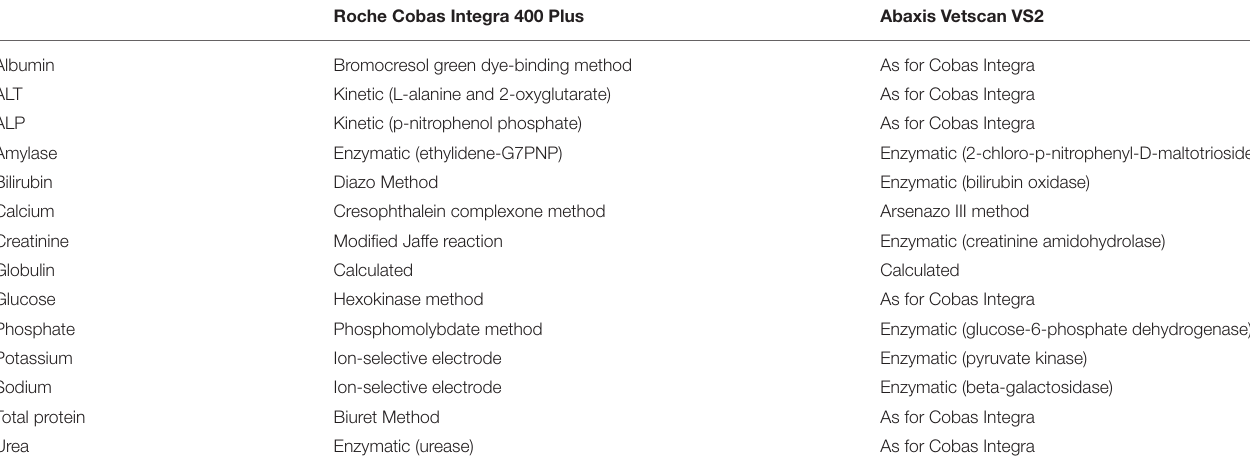
TABLE 1 | Analytical methods utilized by the Abaxis Vetscan VS2 and Roche Cobas Integra 400 Plus for the analysis of Temminck’s pangolin heparin plasma